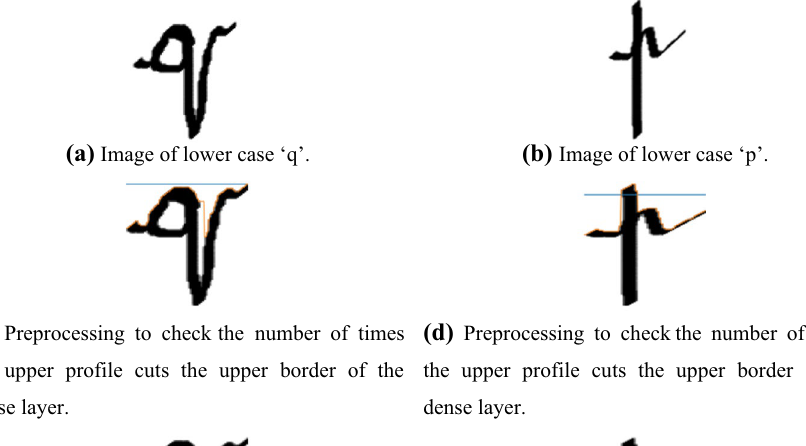
Fig. 6 The working process of the two pre-selection methods works on two similar letters. Though the letter “p” has been written in such a way that the upper part has not been extended much and hence its structure becomes close to “q”. However, our pre-selection method identifies the difference. a Image of lower case ‘q’. b Image of lower case ‘p’. c Pre- processing to check the number of times the upper profile cuts the upper border of the dense layer. d Preprocessing to check the number of times the upper profile cuts the upper border of the dense layer. e Preprocessing to the check number of times the lower profile cuts the lower border of the dense layer. f Pre- processing to check the number of times the lower profile cuts the lower border of the dense